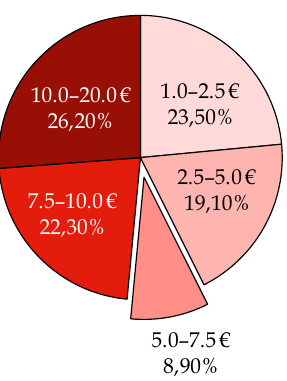
Figure 7. Responses on the monetary level of municipal tax increase (euros per year) citizens accept per year (household level).